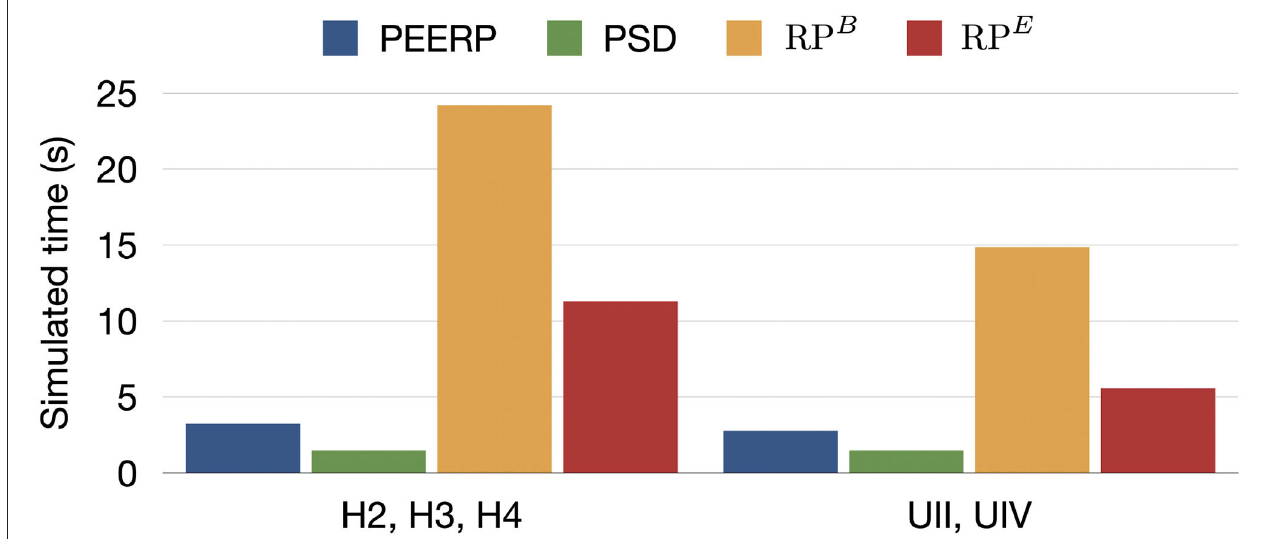
FIGURE 7 | Simulated time required to entirely perform each protocol from one stimulation point ins.